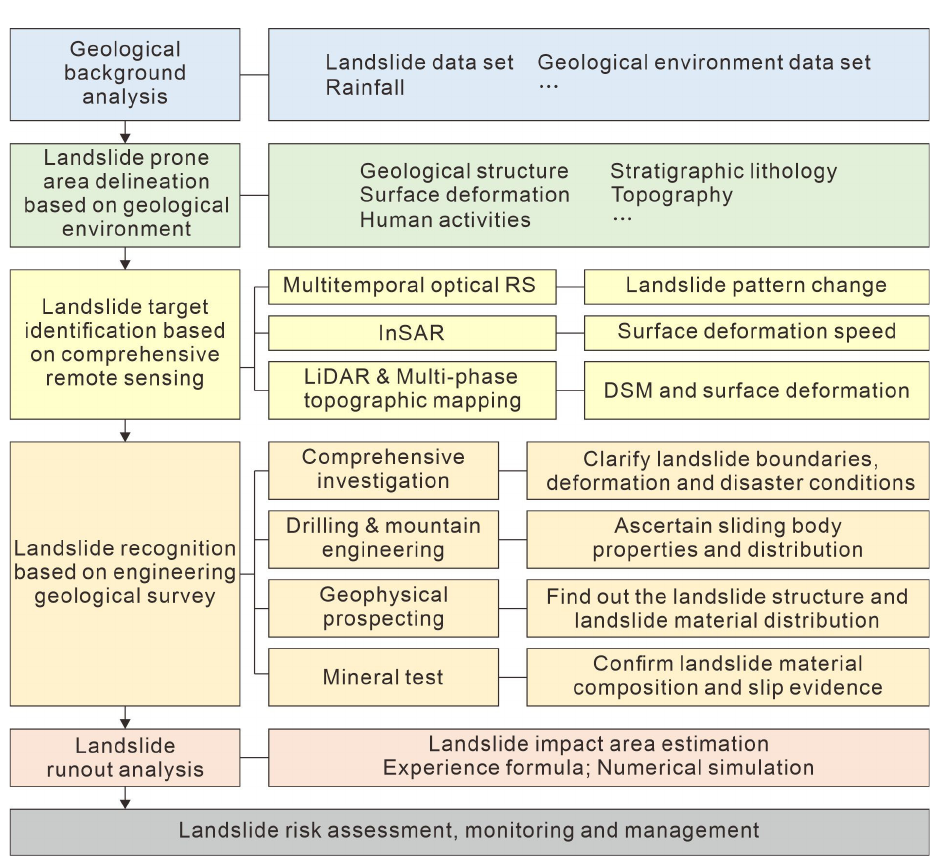
Table 1. Landslide predomination area delineation